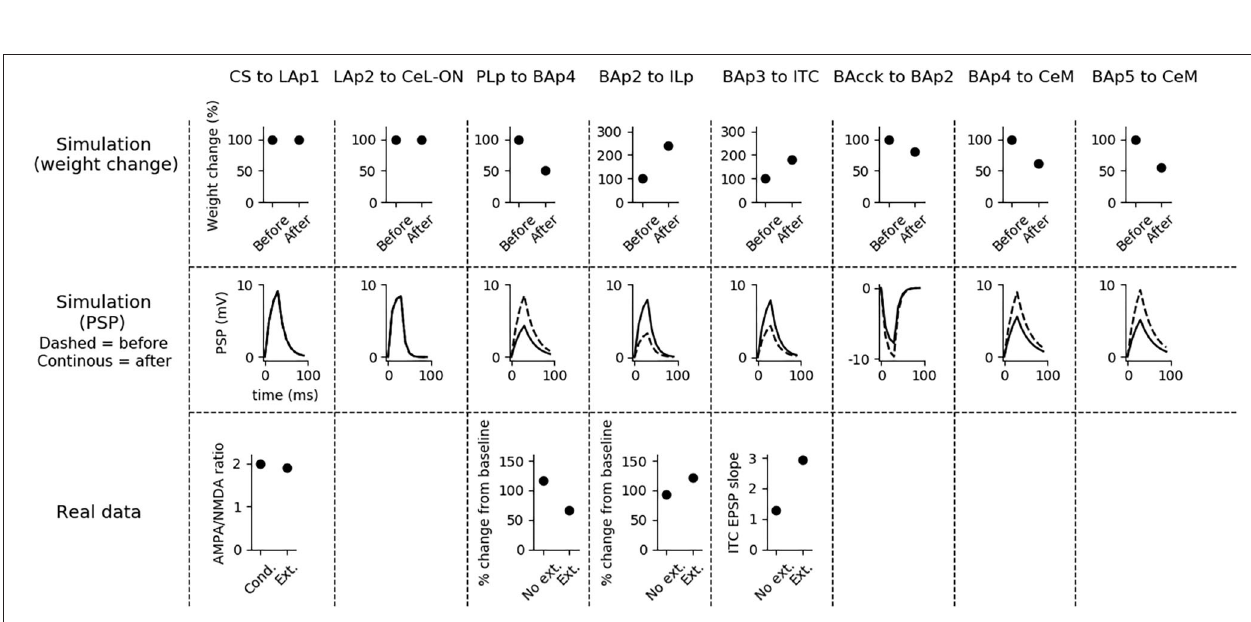
Frontiers in Systems Neuroscience |